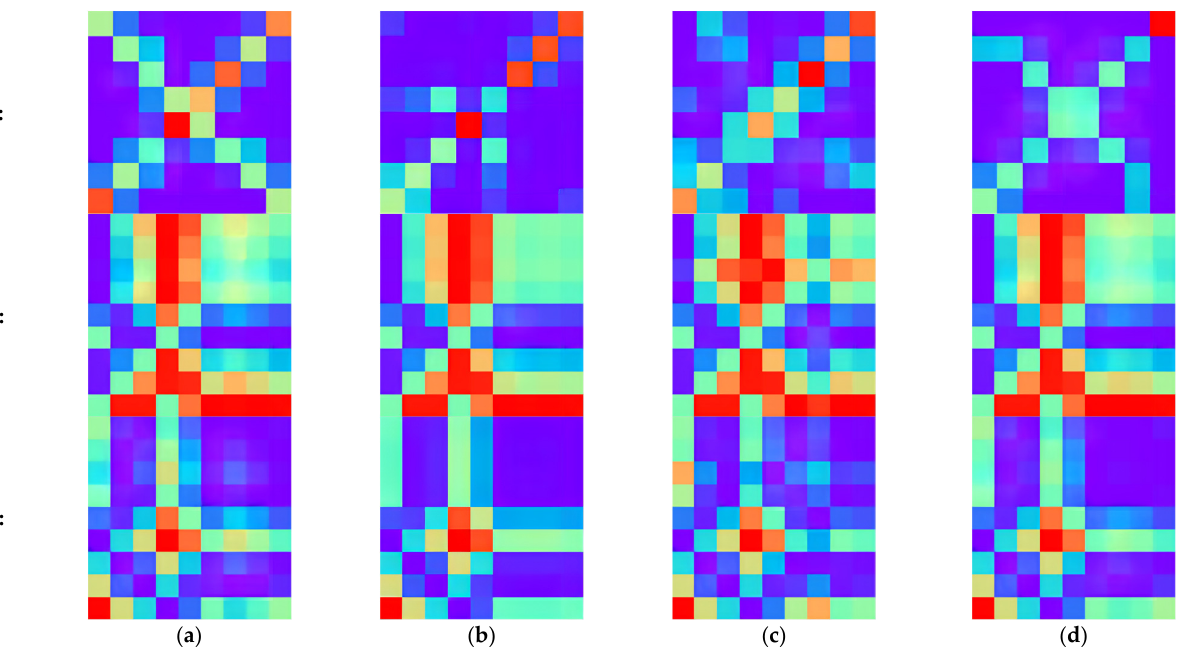
Figure 7. Four types of images encoded with the GAF, GDF and MTF methods ( a – d ). The time-series images represent four defect type classifications: burr, concavity, porosity and no defects.